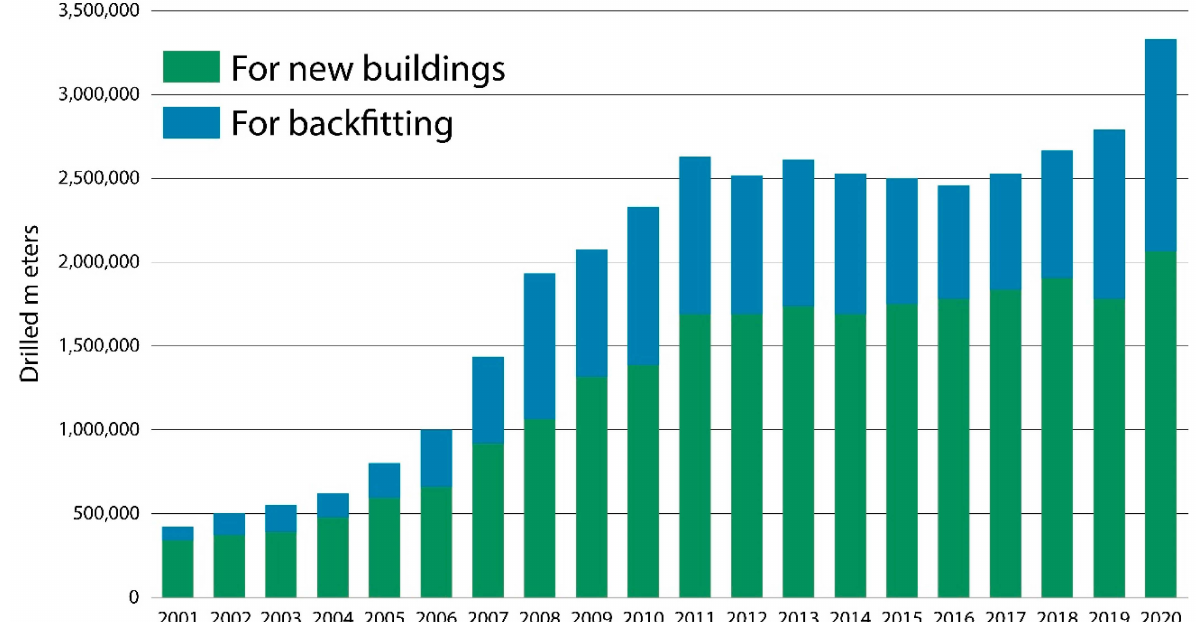
Figure 24. BHE meters drilled per year in Switzerland. From the FWS (Förderverein Wärmepumpen Schweiz) Statistics website https://www.fws.ch/statistiken/. Backfitting means replacing fossil-fired systems with GPHs. For further details, see